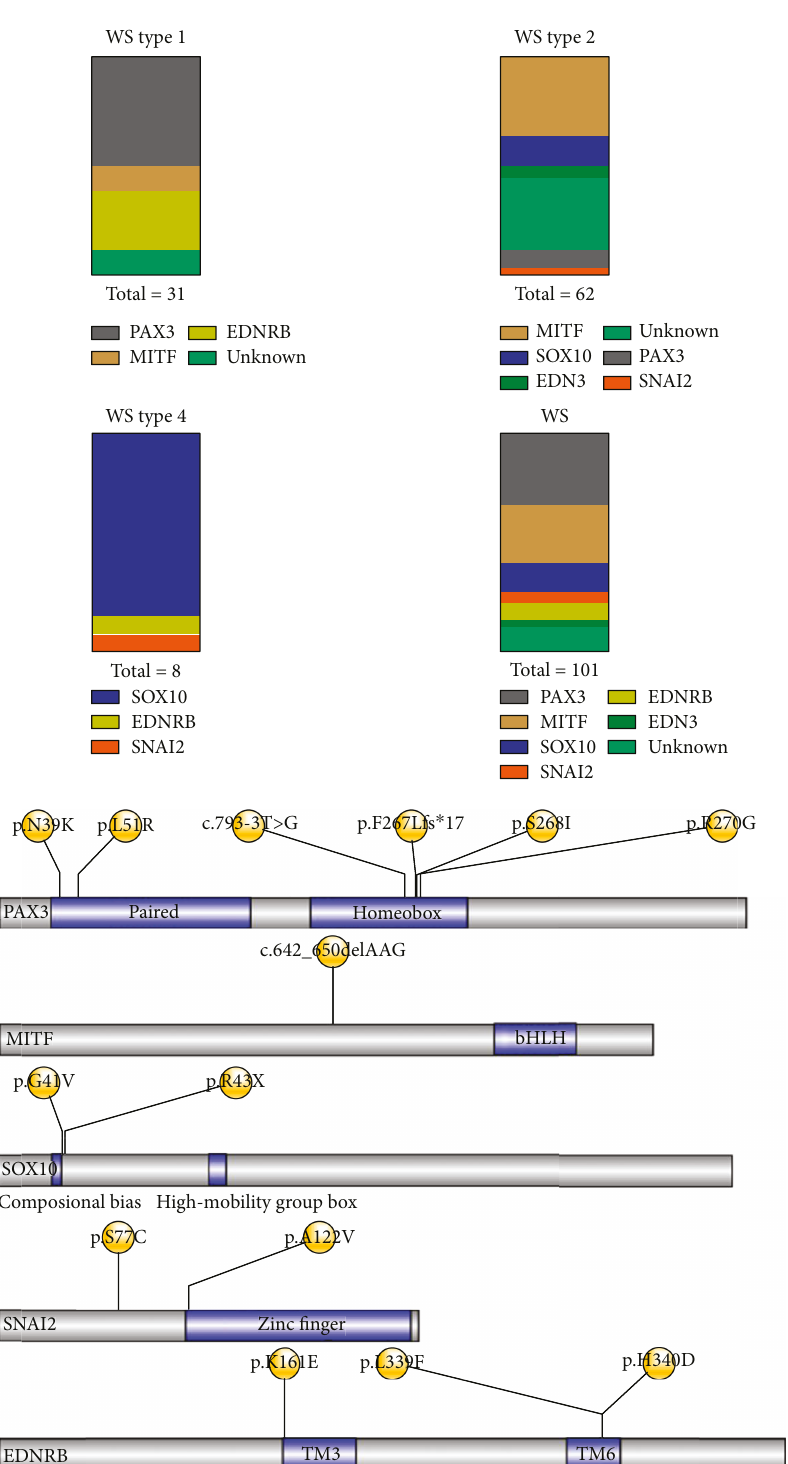
Figure 4: The proportion of genotypes detected in WS types 1, 2, and 4 and the position in the protein domains of the new SNVs detected in our